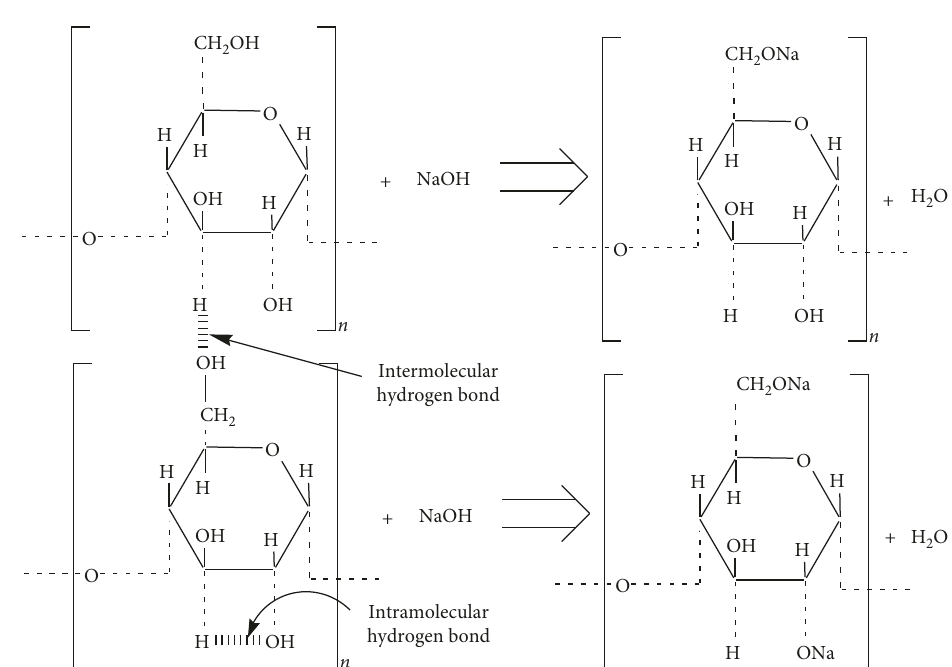
Scheme 3: Effects of sodium hydroxide on changing the starch morphology by breaking intra- and intermolecular hydrogen